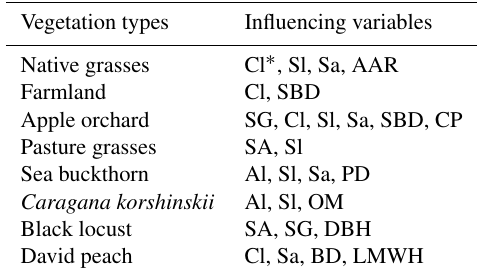
Table 6. Minimum data set of environmental